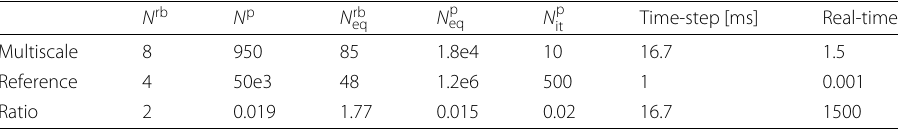
N p N p Time-step [ms] Real-time eq eq it